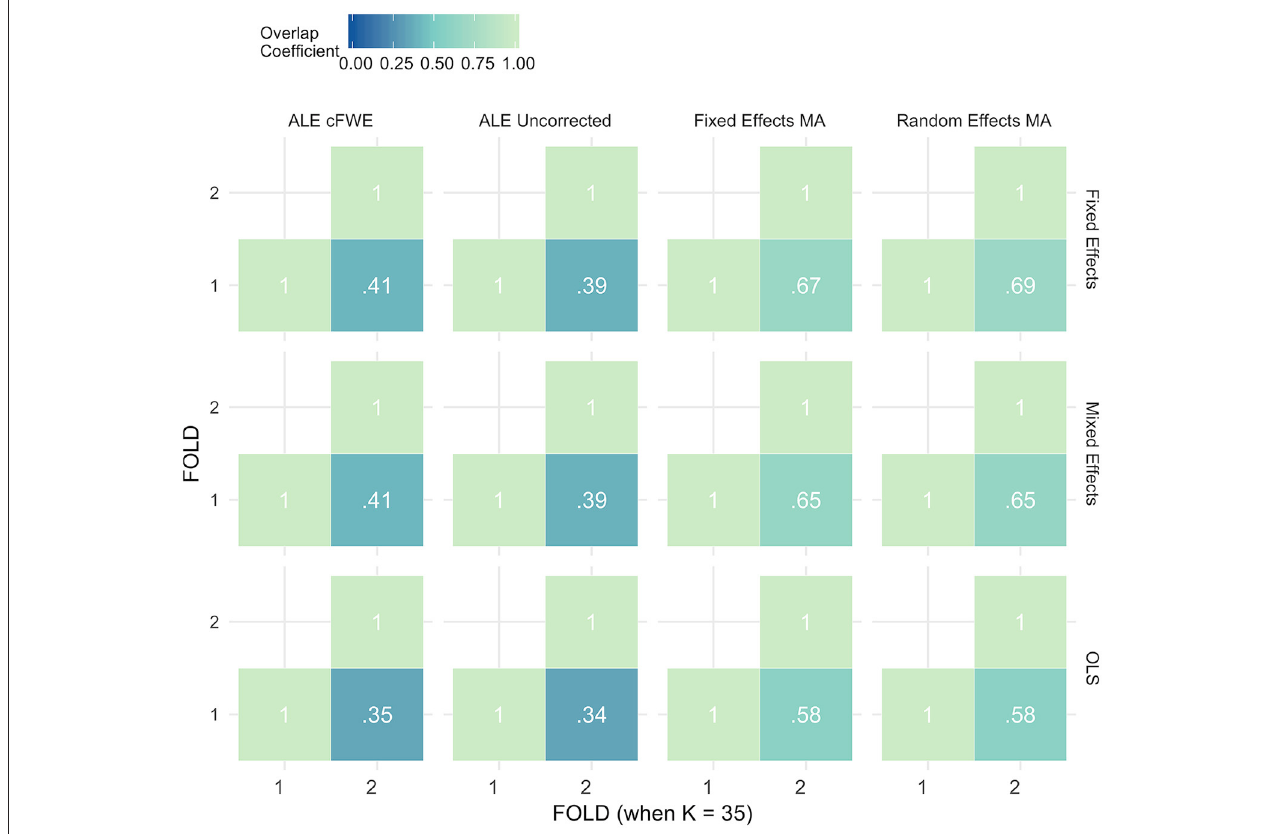
FIGURE 9 | Percent overlap of activation ( ω a , b ) from all pairwise comparisons for K mixed effects and OLS). The columns represent the thresholded meta-analyses. From left to right: ALE cFWE at 0.05, ALE uncorrected at 0.001 and fixed and random effects CBMA at 0.005 with Z >